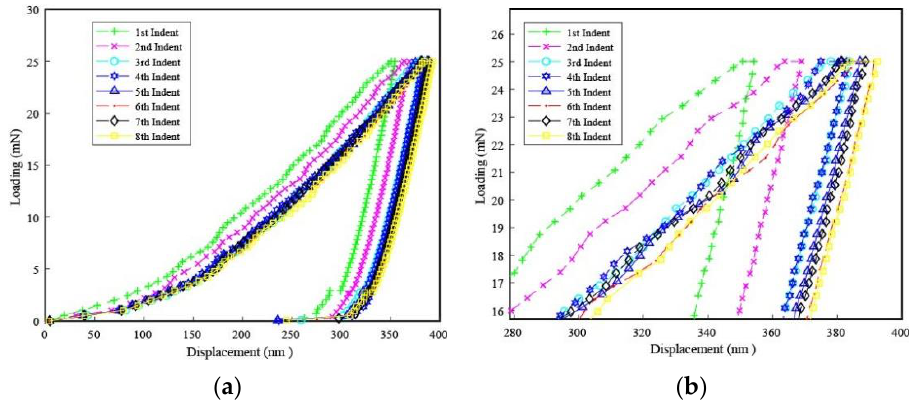
Figure 13. Loading–displacement curves of nano-indents in the subsurface areas of workpiece machined with negative (−10°) rake angles. ( a ) The full view of loading displacement curves and ( b ) corresponding enlarge view of top areas.